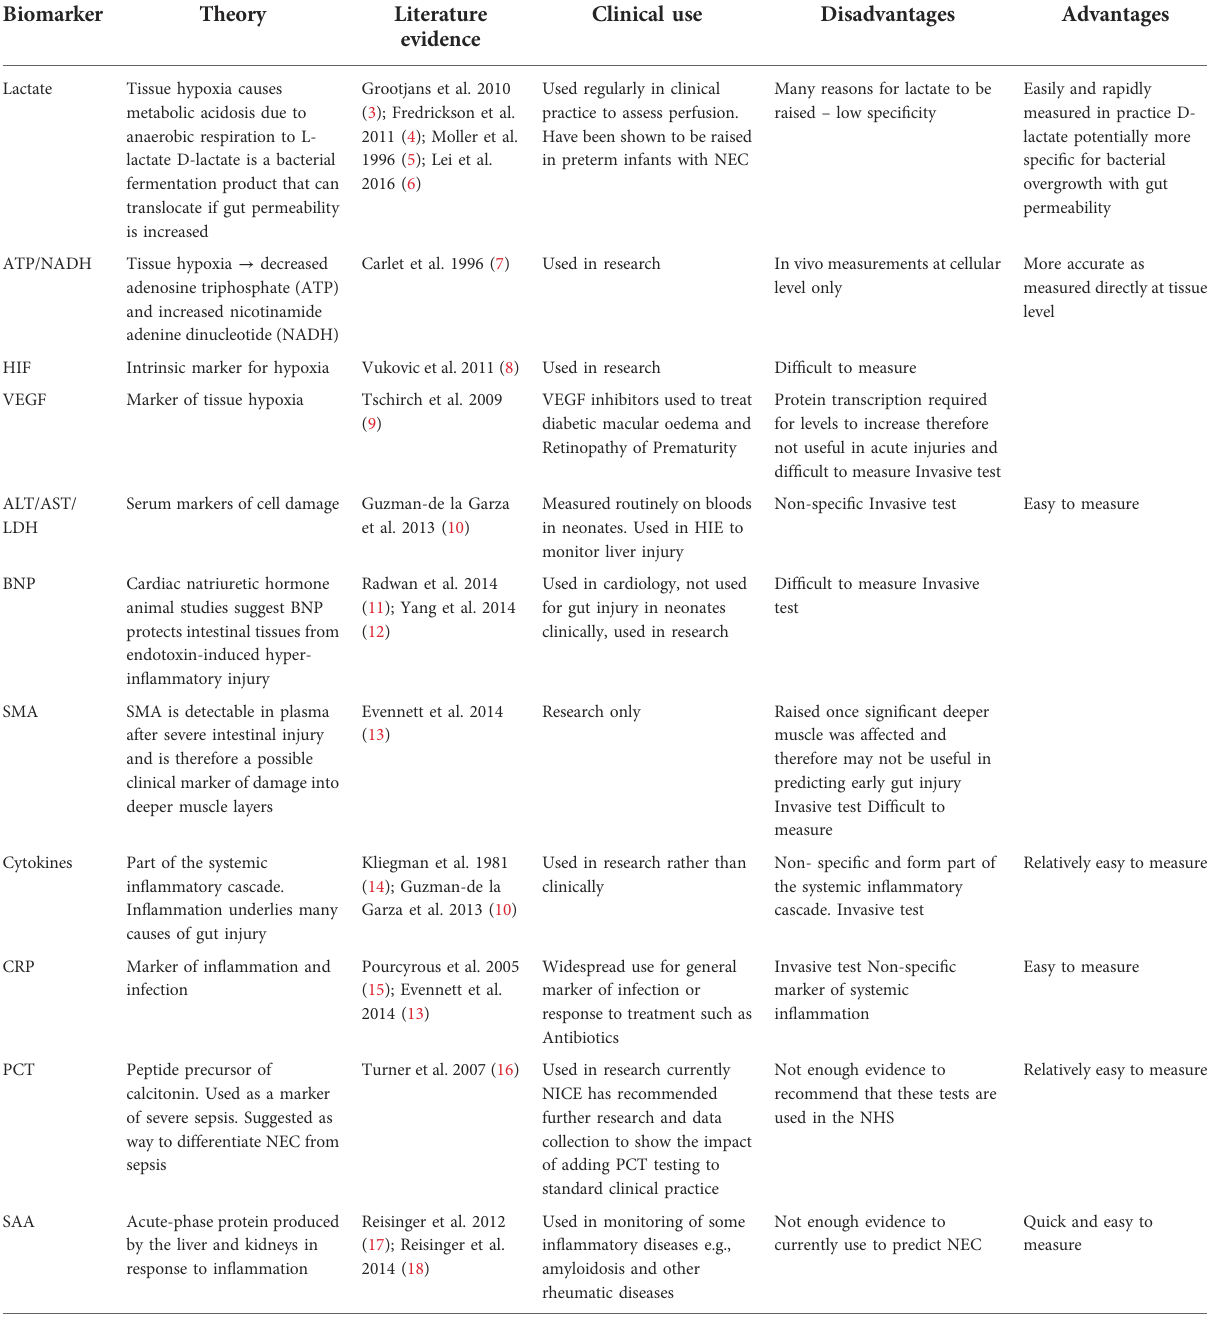
TABLE 1 Summary of the serological markers of ischaemia, hypoxia and in fl ammation which have been reported as potential biomarkers of gut in fl ammation/injury.